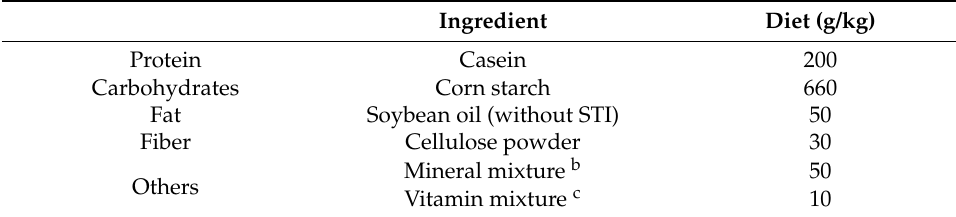
Table 1. Composition of the control diet a . Ingredient Diet (g/kg) Protein Casein 200 Carbohydrates Corn starch 660 Fat Soybean oil (without STI) 50 Fiber Cellulose powder 30 Mineral mixture b 50 Others Vitamin mixture c